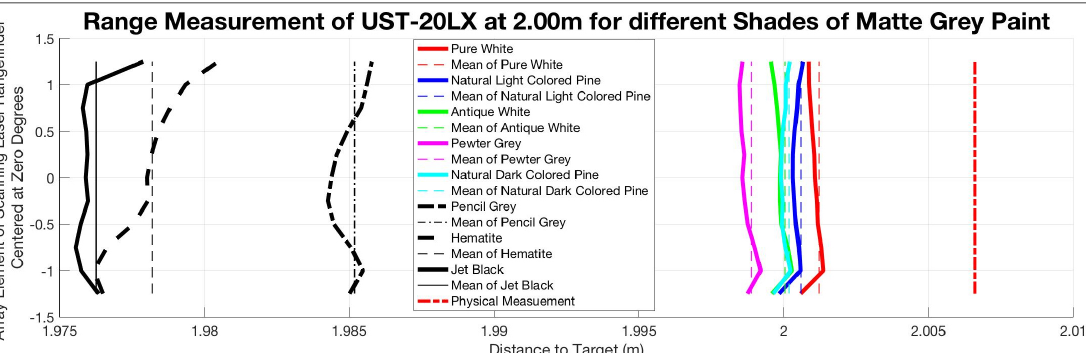
Figure 8. Gray level results at 2 m.